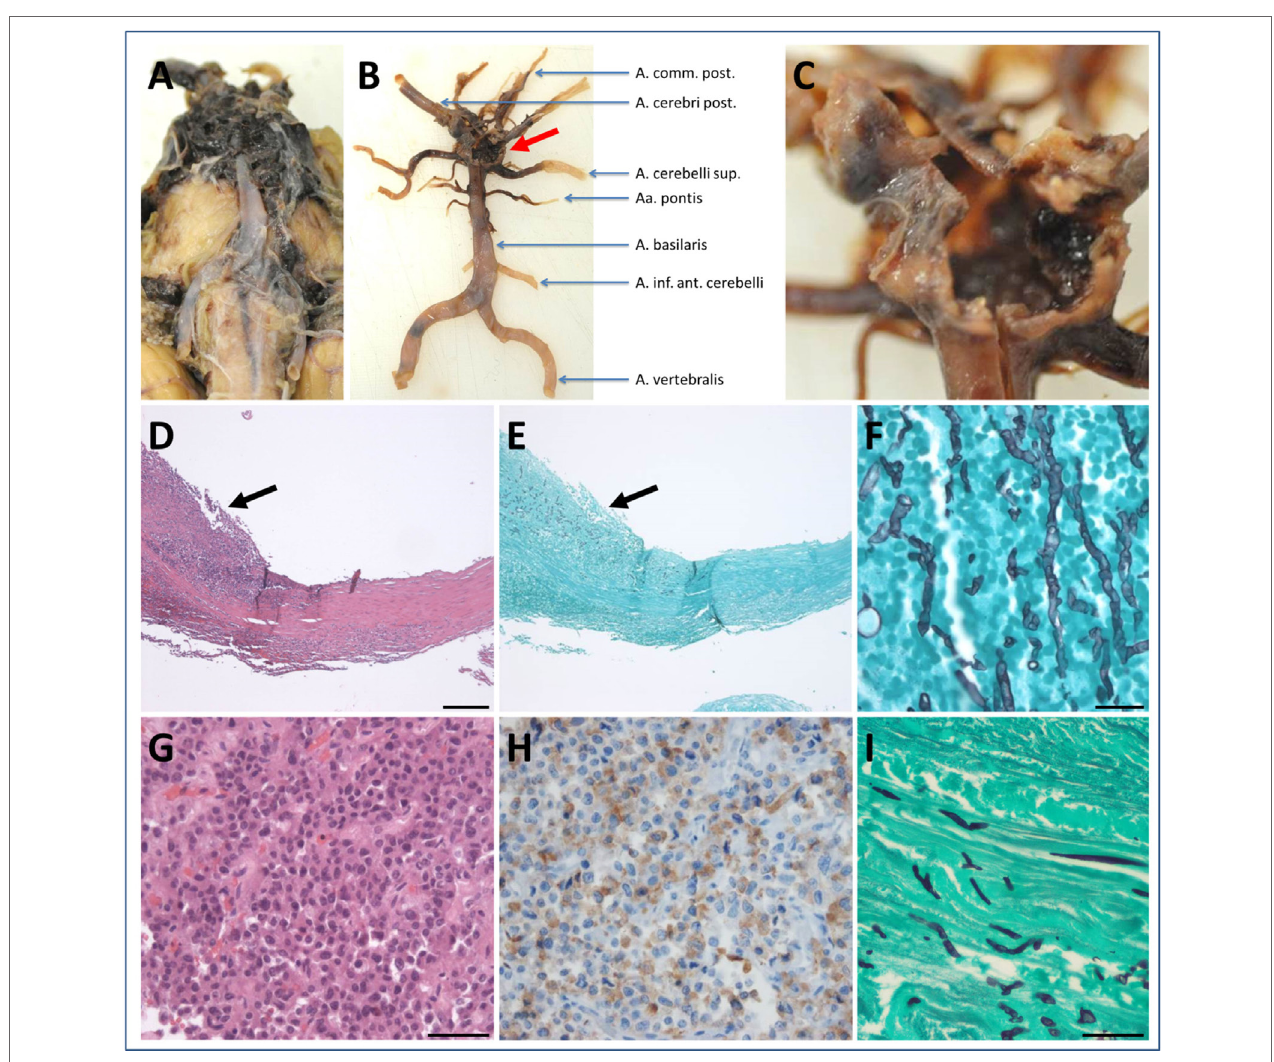
FIGURe 3 | Neuropathological findings. Macroscopic findings (a–C) : (a) subarachnoid hemorrhage within the basal cisterns coating the midbrain and pons and extending to the cerebellopontine angle. (B) Macroscopic view of the vertebrobasilar vascular supply after preparation of the hematoma clearly showing an aneurysm at the basilar tip (red arrow). Higher magnification in (C) demonstrates the ruptured aneurysm. Microscopic findings (D–I) : (D) hematoxylin & eosin (H&E) staining of the basilar aneurysm showing thickening and splitting of the wall due to intramural inflammatory infiltrates (arrow). (e) Same area as depicted in (D) the presence of hyphal structures in close association to the inflammatory infiltrates confirms the diagnosis of a mycotic aneurysm (Grocott histochemistry). (F) Higher magnification of (e) (Grocott histochemistry). (G) A pituitary adenoma visible in the sellar region (H&E staining) with immunohistochemical expression of adrenocorticotrophic hormone (H) proving the diagnosis of a corticotroph adenoma. (I) Hyphal structures within the dura adjacent to the corticotroph adenoma (Grocott histochemistry). Scale bar in (D) 200 µm, applies also for (e) . Scale bar in (F) 20 µm. Scale bar in (G) 50 µm, applies also for (H) . Scale bar in (I) 100